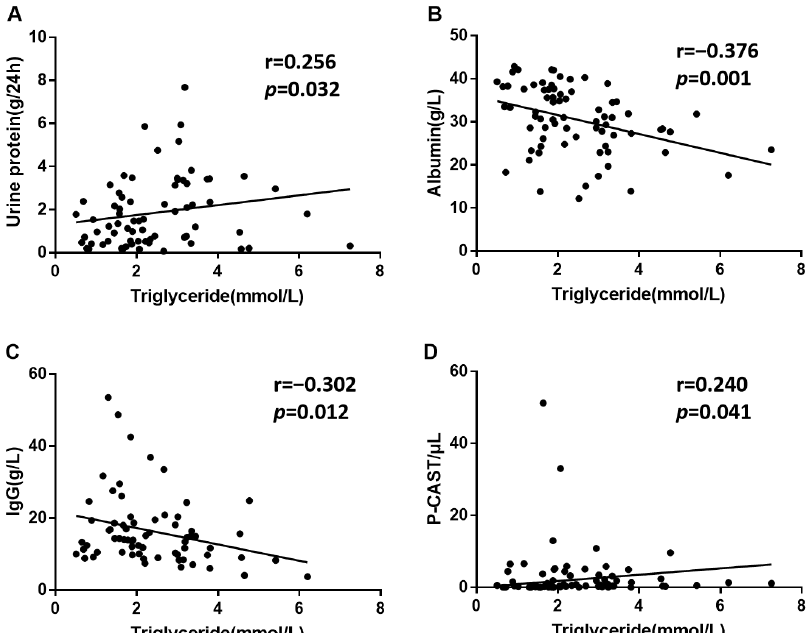
Figure 2. The correlations between triglycerides and indicators of SLE-related kidney injury, including urine protein ( A ), IgG ( C ), and P-CAST ( D ), were determined by Spearman correlation analysis in patients with SLE-related kidney injury. The correlation between triglycerides and albumin ( B ) was determined by Pearson correlation analysis. p < 0.05 was considered statistically significant. IgG: immunoglobulin G; P-CAST: urine pathology cast.